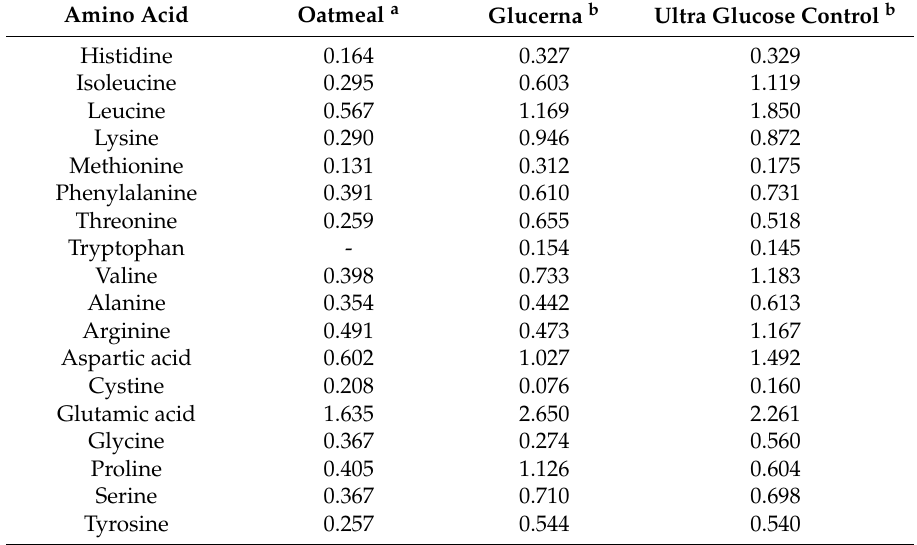
Table 3. Amino acids composition of the three breakfast